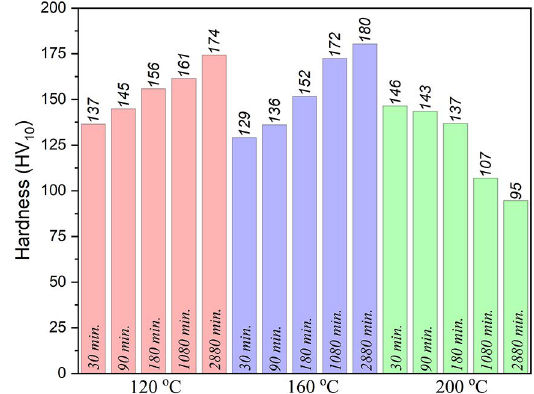
Figure 20. Effect of different aging temperatures and time on hardness